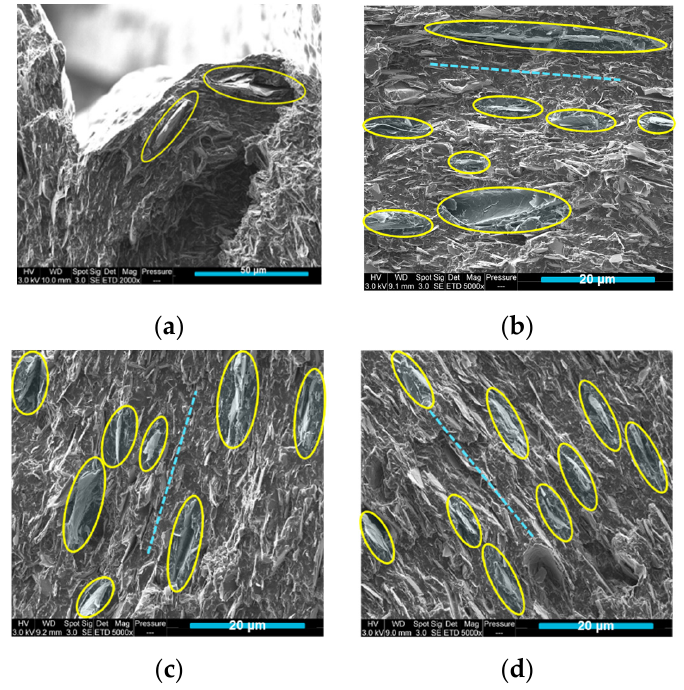
Figure 8. ( a ) SEM image of 3D-printed PLA/PCL/15 wt% M5; ( b – d ) SEM images of injection- moulded PLA/PCL/15 wt.% M5 composite (The yellow ellipses are surround some graphene flakes and the dotted lines indicate the similar orientation of the graphene platelets in the injection moulded samples).